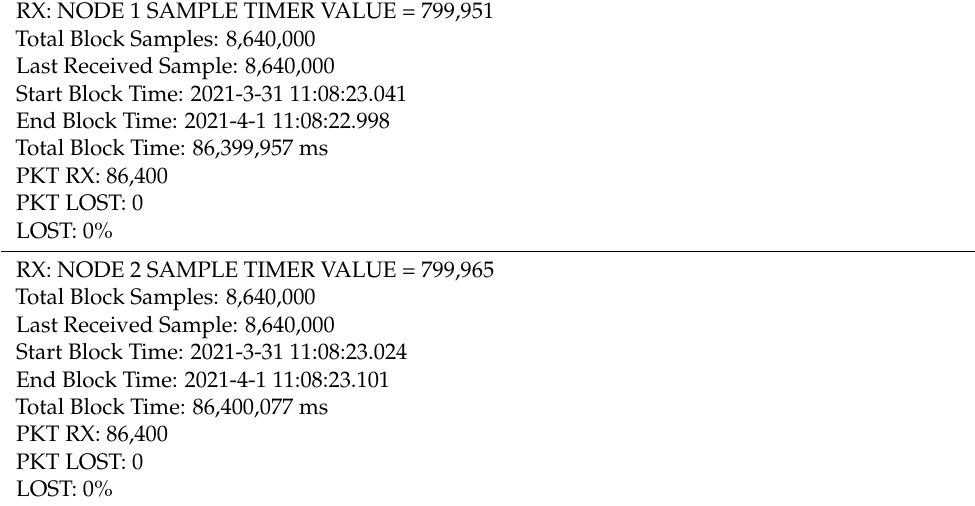
Table 3. Results of 24 h register calibration with new values of the Timer_A0 counter.